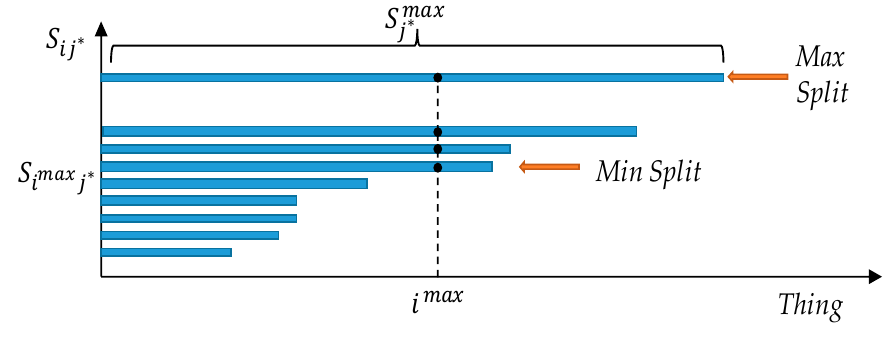
Figure 3. SplitPolicy example.